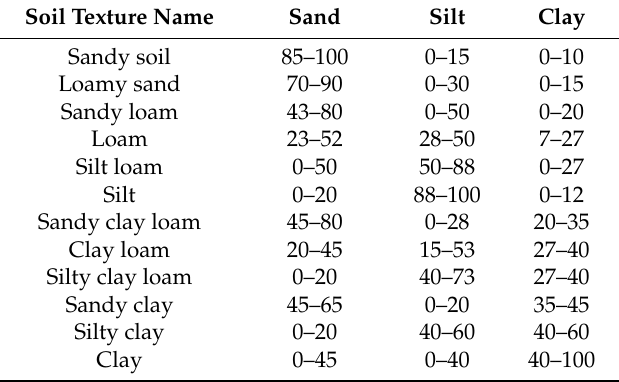
Table 3. Soil textural classification using the percent of sand, silt and clay content (adapted from the United States Department of Agriculture (USDA) soil texture triangle [47]).